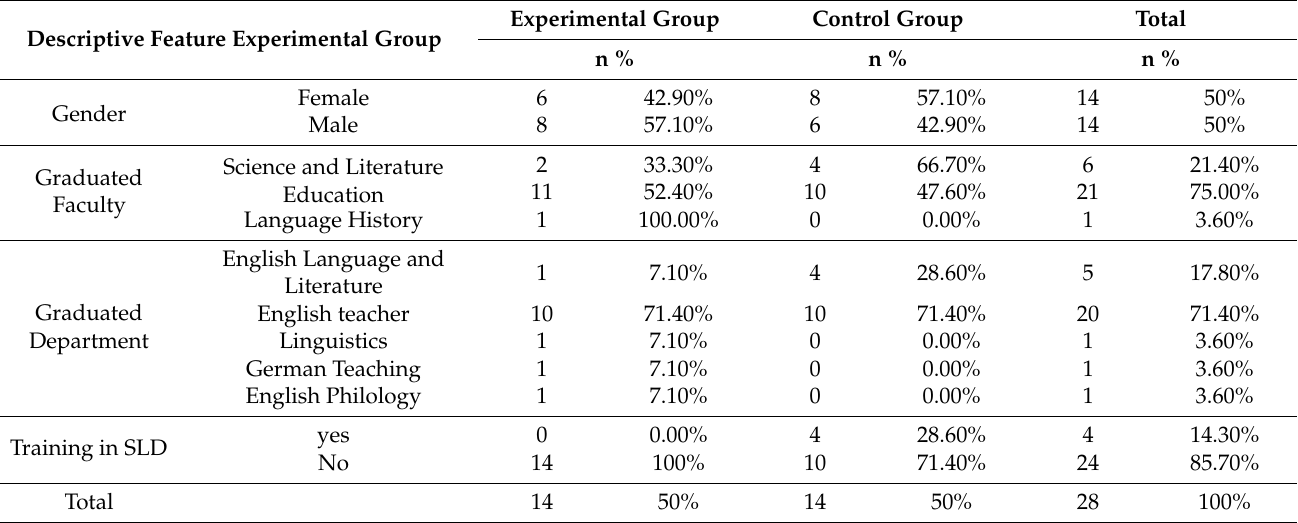
Table 2. Descriptive characteristics of the